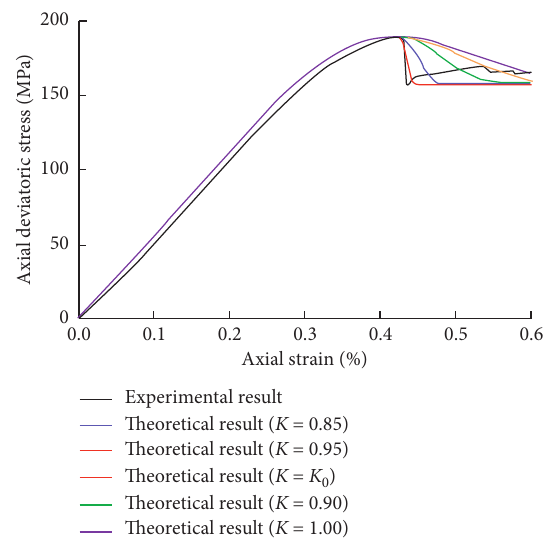
Figure 8: The influence of correction factor on the stress-strain